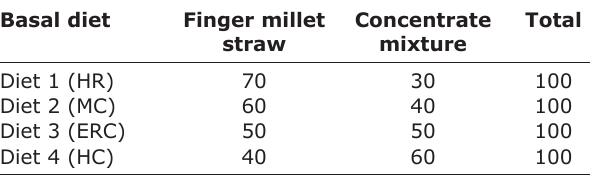
Table-2: Different dietary regimes and silkworm pupae oil levels in vitro Table-1: Composition of basal diet combinations (on dry matter basis). Basal diet Finger millet Concentrate straw mixture